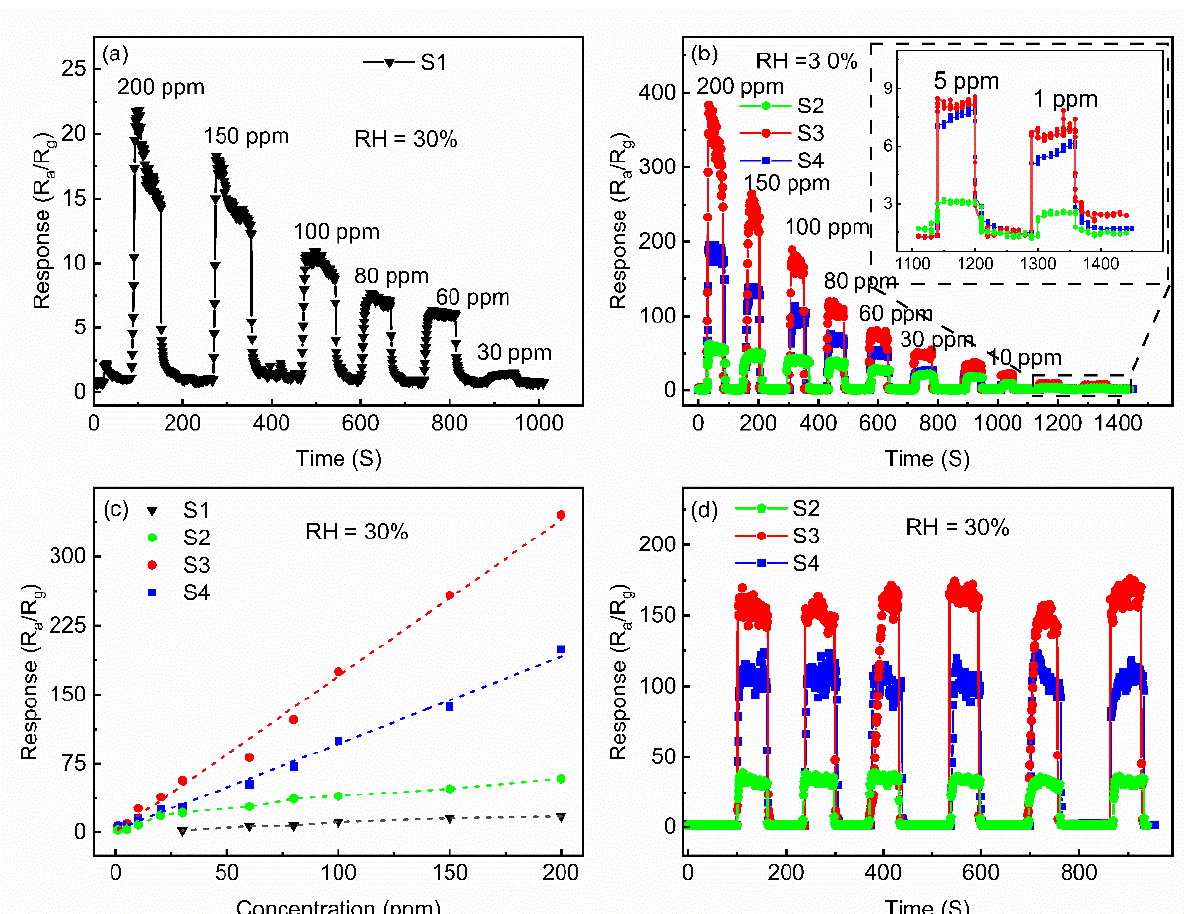
Figure 7. Transient response/recovery curves of pure ZnO nanofilm ranging from 30 to 200 ppm ( a ) and of Au@ZnO nanofilms ranging from 1 to 200 ppm ( b ); linearly fitting curve of response for the as-obtained samples ( c ); six periods of transient response/recovery curves of the Au@ZnO nanofilms to 100 ppm IPA at 300 °C ( d ). Table 2. Comparisons with the sensing properties of MOS-based IPA sensors reported in previous research.